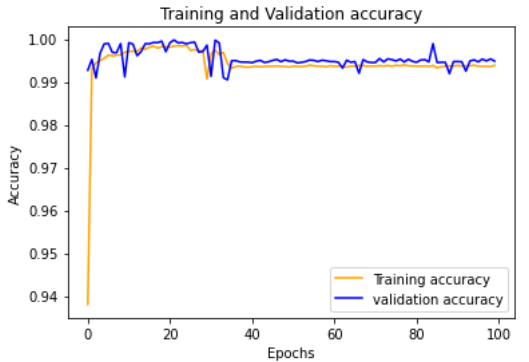
Figure 4. Training and validation accuracy with 100 epochs.